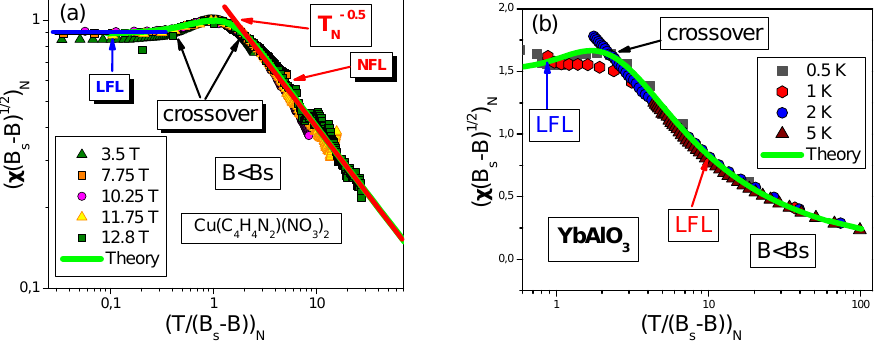
Figure 12. The normalized magnetic susceptibility χ N extracted from measurements at B < B s . Panel ( a ): χ N extracted from measurements on CuPzN [25]. Panel ( b ): χ N extracted from measurements on YbAlO 3 [24]. Our theoretical curve, plotted based on Equations (12) and (14), is represented by the solid line (shown in Figure 10a) tracing the scaling. It is seen that the dependence χ N for YbAlO 3 has three regions: LFL, crossover and